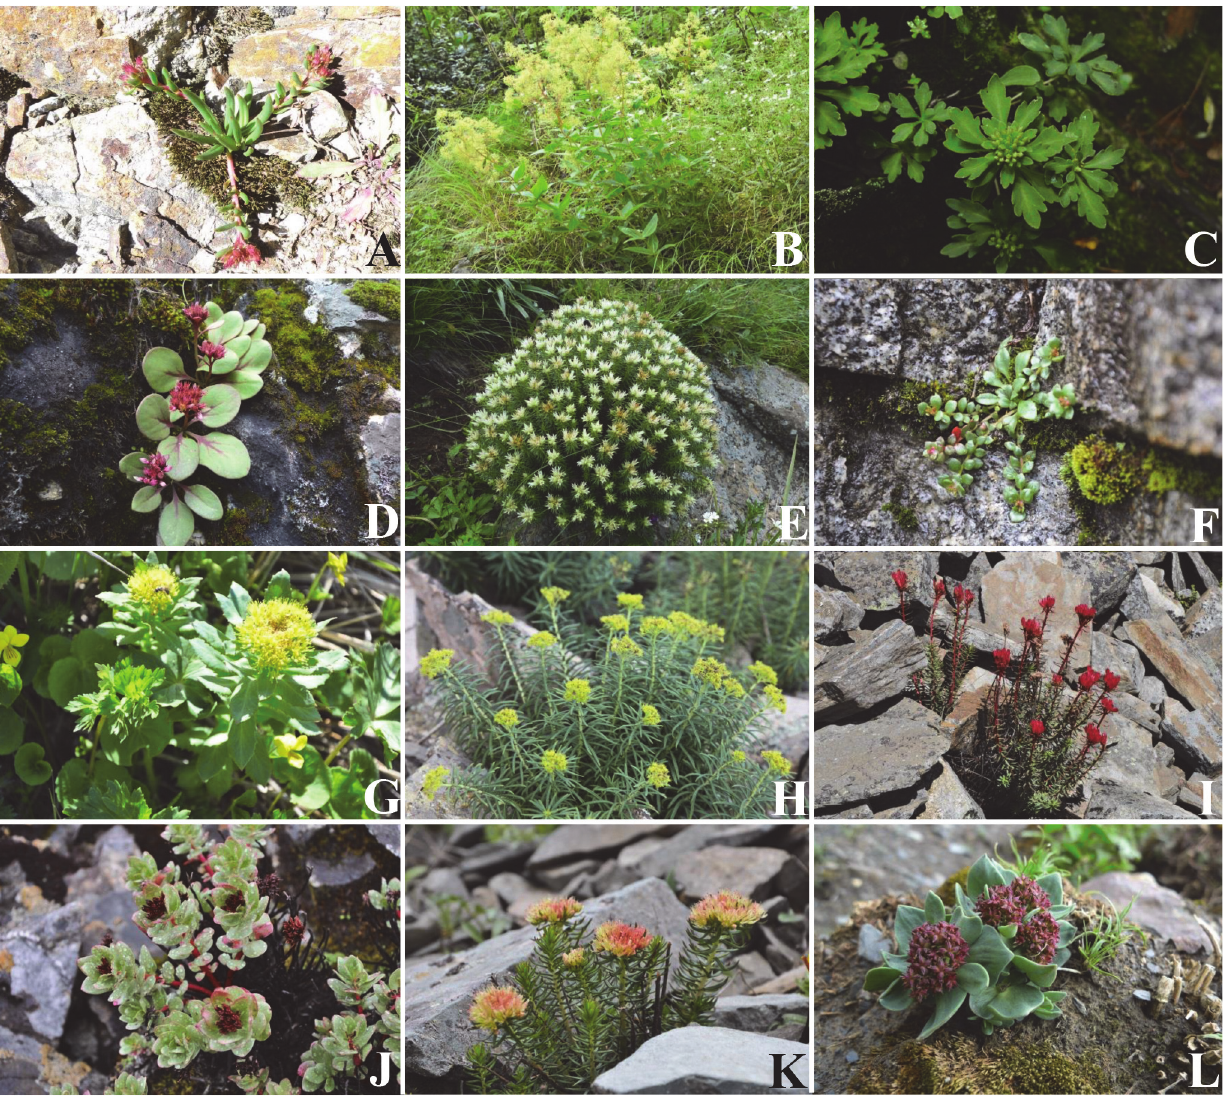
Fig 1. Representatives of species illustrating the morphological variation in Rhodiola. (A. Rhodiola smithii ; B. R . yunnanensis ; C. R . chrysanthemifolia ; D. R . prainii ; E. R . dumulosa ; F. R . hobsonii ; G. R . rosea ; H. R . kirilowii ; I. R . fastigiata ; J. R . crenulata ; K. R . alsia ; L. R . bupleuroides